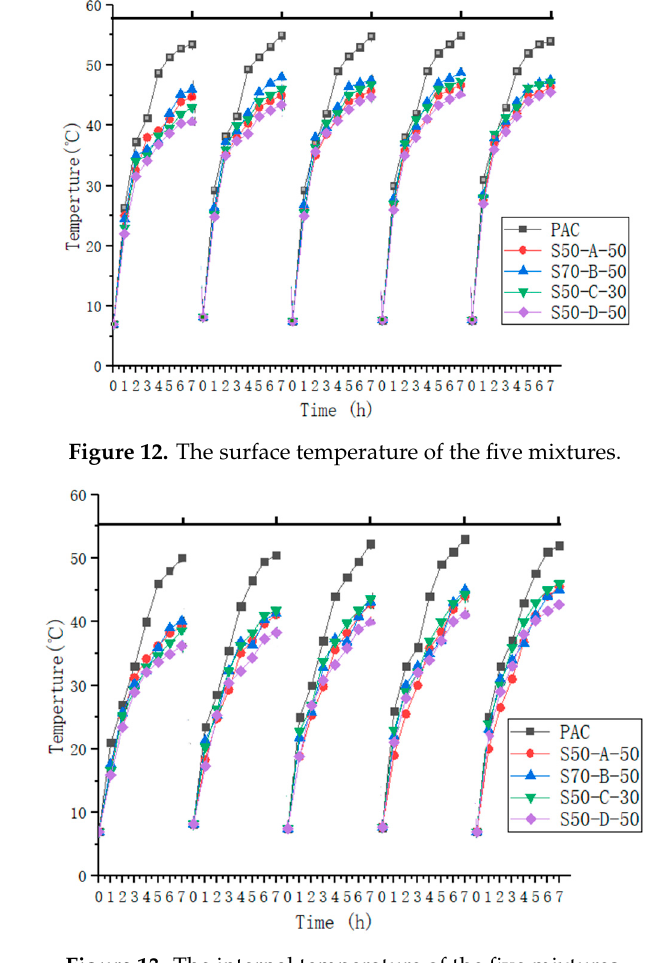
Figure 14. The surface and internal temperature in the first cycle.